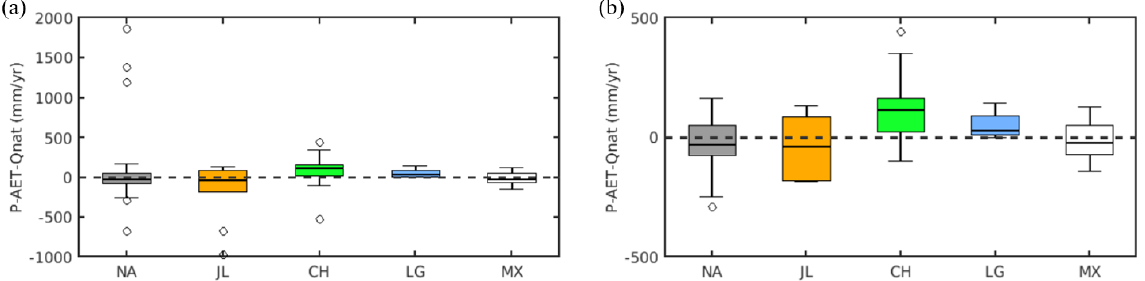
Figure 4. Distribution of annual average reach water balance metrics for each lithology for the Thames at Kingston reaches from 1994–2014 inclusive, showing unaccounted for annual water volume from precipitation after subtraction of actual evapotranspiration and naturalised river flow (in millimetres per year). A positive water balance residual indicates a losing reach and a negative water balance residual a gaining reach at the annual time scale. The boxes show the interquartile interval, within which 50% of the data lies, and the horizontal line the median value. The whiskers show the minimum and maximum values, excluding outliers. The plot in (a) shows all data and the plot in (b) is focussed in to ± 500mmyr − 1 , thereby excluding some wider outliers. Reaches have been categorised based on > 70% catchment geological coverage. CH: Chalk ( n = 23), JL: Jurassic limestone ( n = 11), LG: Lower Greensand ( n = 4), NA: non-aquifer ( n = 28) and MX: mixed ( n = 14).